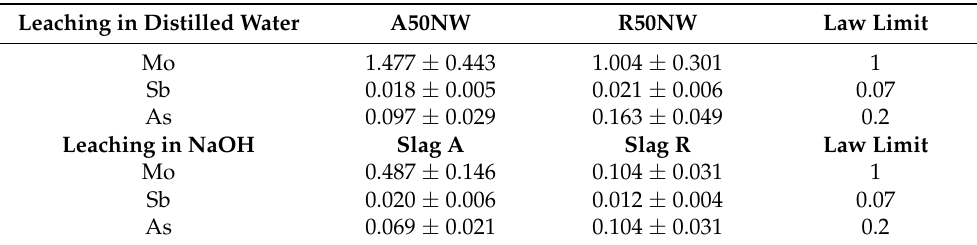
Table 6. Amphoteric elements (mg/L) released before and after alkali